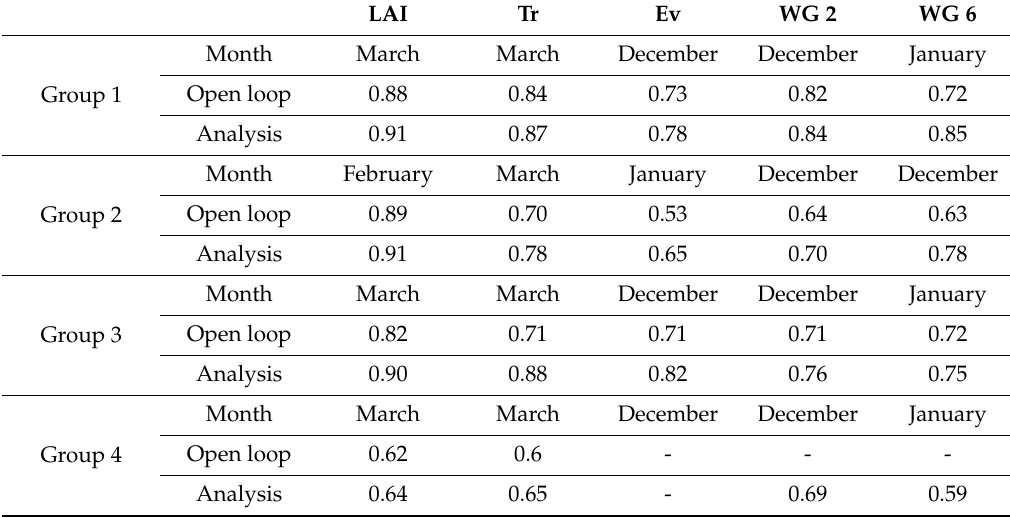
Table 5. Correlation between output of the LSM with and without data assimilation and cereal yields at the group scale. Only the maximum correlation time already identified in Section 3 is displayed. All correlation coe ffi cients are significant at the 99%